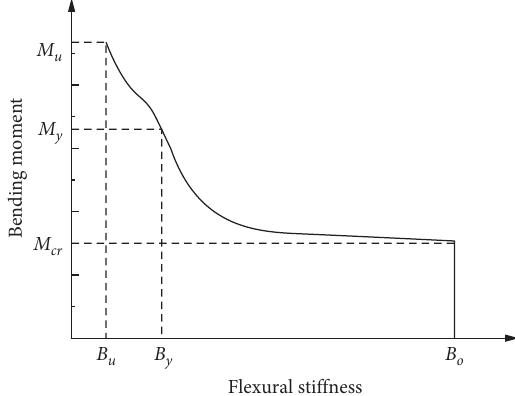
Figure 11: Characteristics of moment-stiffness curve.